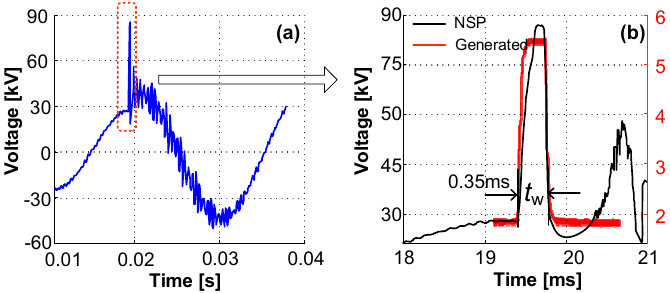
Figure 12. Square voltage impulse superimposed on 50 Hz AC voltage. ( a ) Field measured voltage from the low-voltage side of the traction substation transformer during neutral section passing; ( b ) the generated voltage impulse and partially magnified impulse of ( a ).